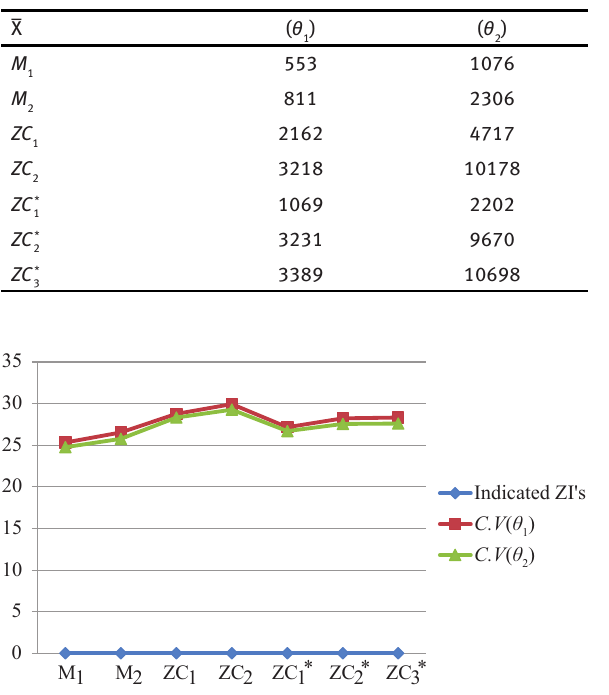
— Table 4: Different values of X of the indicated Zagreb indices for and T . both operations T 1 2